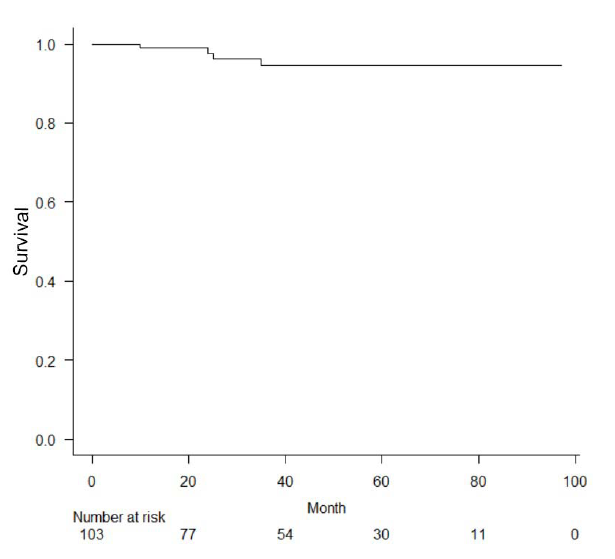
Fig. 2 - Survival free from overall death.